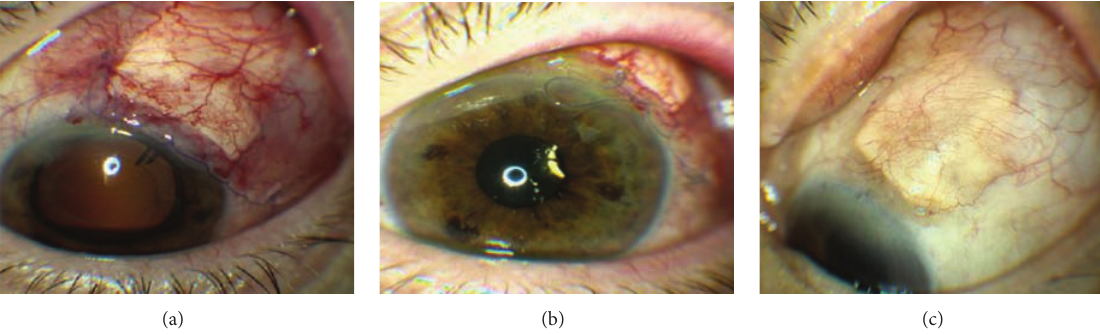
Figure 2: (a) 1 day s/p surgery. (b) 22 days s/p surgery. (c) 90 days s/p surgery.